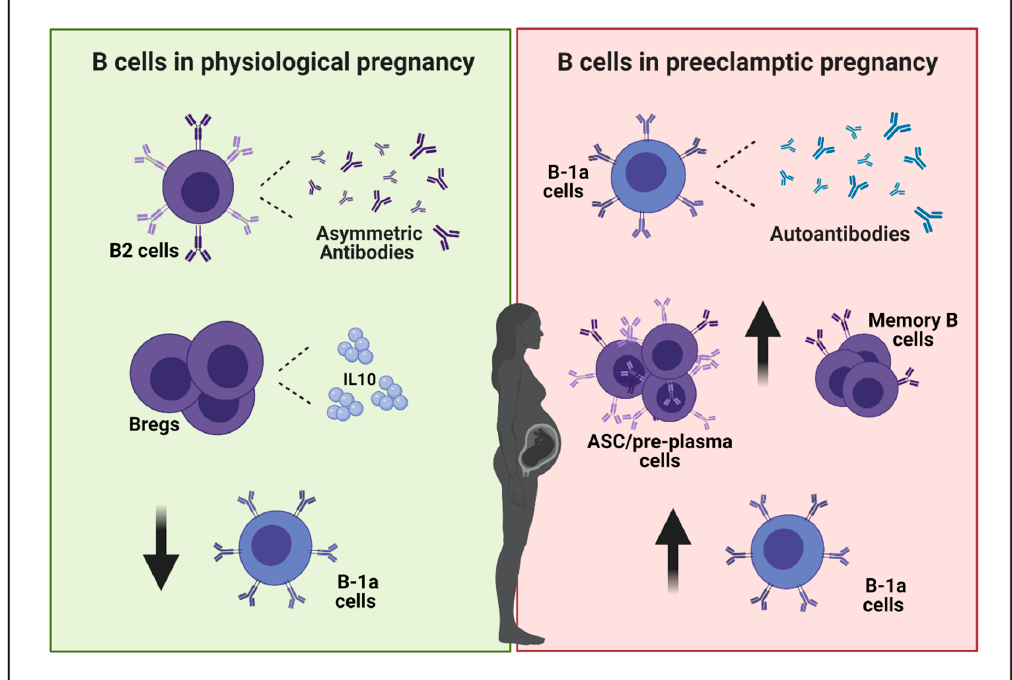
Figure 1. B cells and pregnancy. During physiological pregnancy B cells contribute to establish a tolerant environment. B2 cells generate asymmetric antibodies that bind paternal antigens but do not produce responses against them, protecting the fetus against a potential induction of the maternal lymphocyte response against paternal antigens. Moreover, regulatory B cells are found to be enhanced in healthy pregnancies, and they contribute to establishing a tolerant environment through the production of the anti-inflammatory IL-10. On the other hand, besides protective antibodies, the production of auto- antibodies (such as AT1-AA, antibodies against protein C and protein S) can be detrimental for pregnancy and characterize PE. A few indications suggest a role for B-1a cells in the production of these autoantibodies. A significant decrease in the frequency of B-1a cells has been reported in the peripheral blood of healthy pregnant women, while it has been reported to be elevated in patients with PE. Additionally, the percentage of memory B cells and plasma cell precursors increases in preeclamptic women. PE, preeclampsia; Bregs, regulatory B cells; IL-10, interleukin 10; ASC, antibody-secreting cells; AT1-AA, angiotensin receptor 1-autoantibodies. Created with BioRender.com (accessed on 21 February